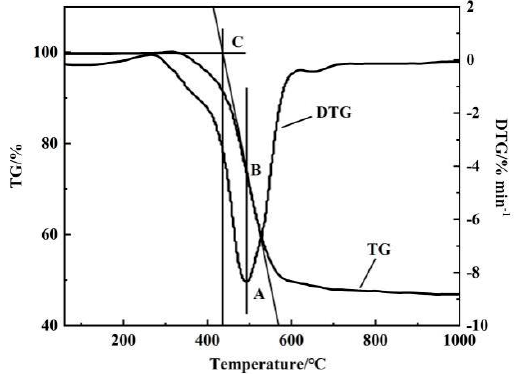
Figure 1. TG–DTG curve [25–27].